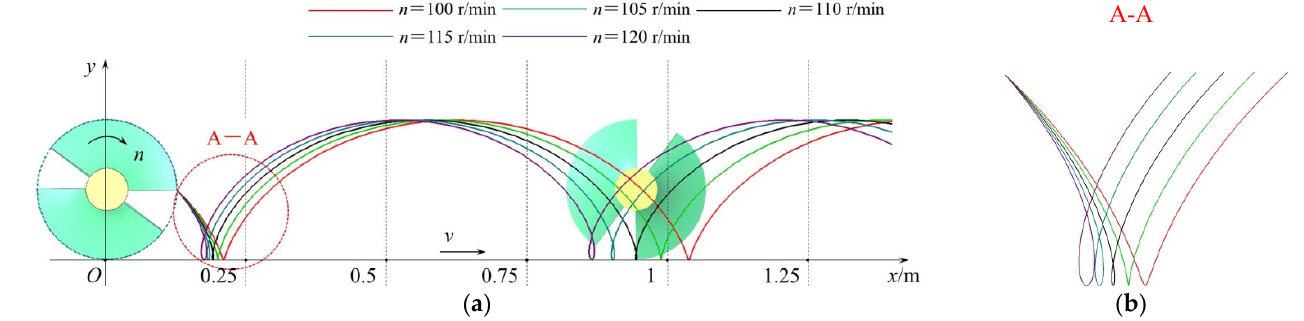
Figure 9. The motion trajectory of the tip of the RB with different values of n . ( a ) The overall trend of the moving trajectory of the RB during the operation; ( b ) partially enlarged schematic of area A-A. Note: n is the RVSS, rpm; v is the operating velocity of machines, km/h.